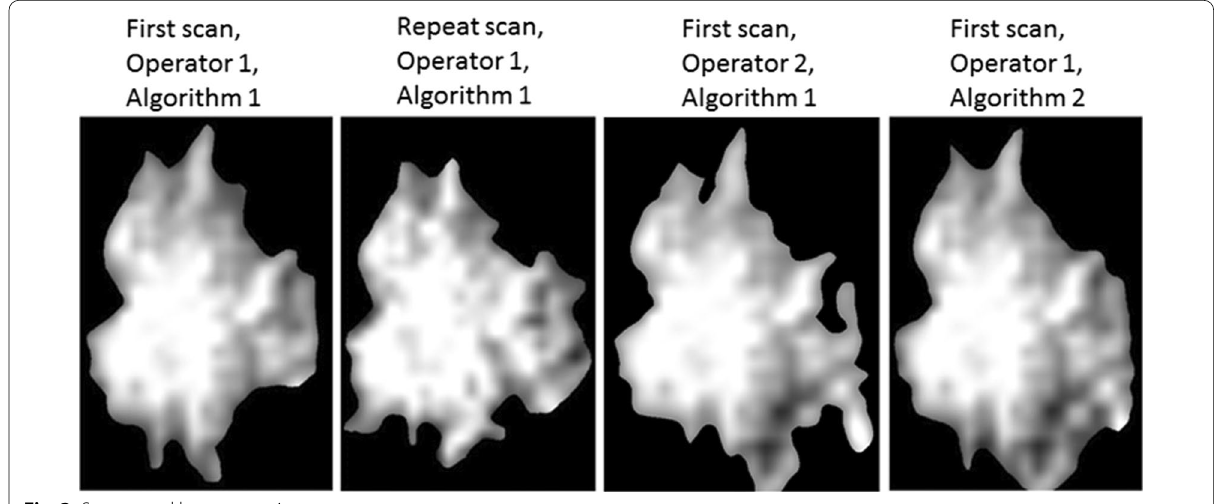
Fig. 3 Segmented lung cancer